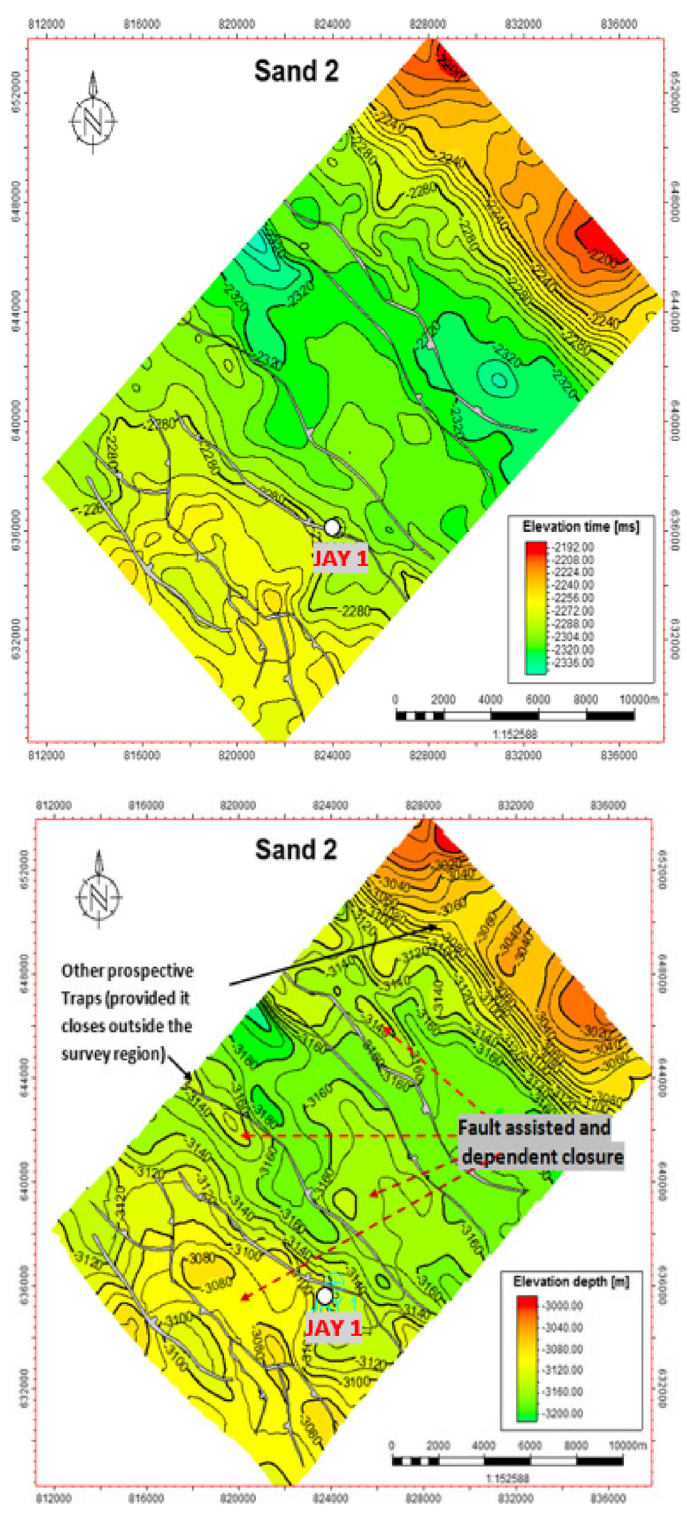
Fig. 14 Time and depth map of sand